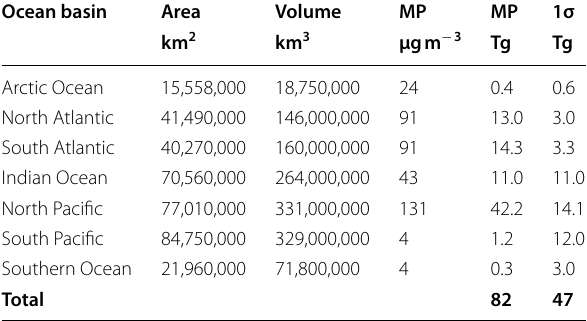
Atlantic, N-Pacific and Arctic Ocean data from Table 1. Microplastics (MP) include fragments and fibers in the 0.3 – 5 mm (LMP) and < 0.3 mm (SMP) range. Data for the S-Pacific and Southern Ocean are extrapolated based on surface Ocean data from Shim et al. [29] with uncertainties set to 10x. No data exists for the Indian Ocean, where concentrations were assumed equal to the S-Atlantic observations by Eo et al. [34] (Table 1). Subsurface oceanic budgets in Tg include do not include the mixed layer (upper 0.1 km)